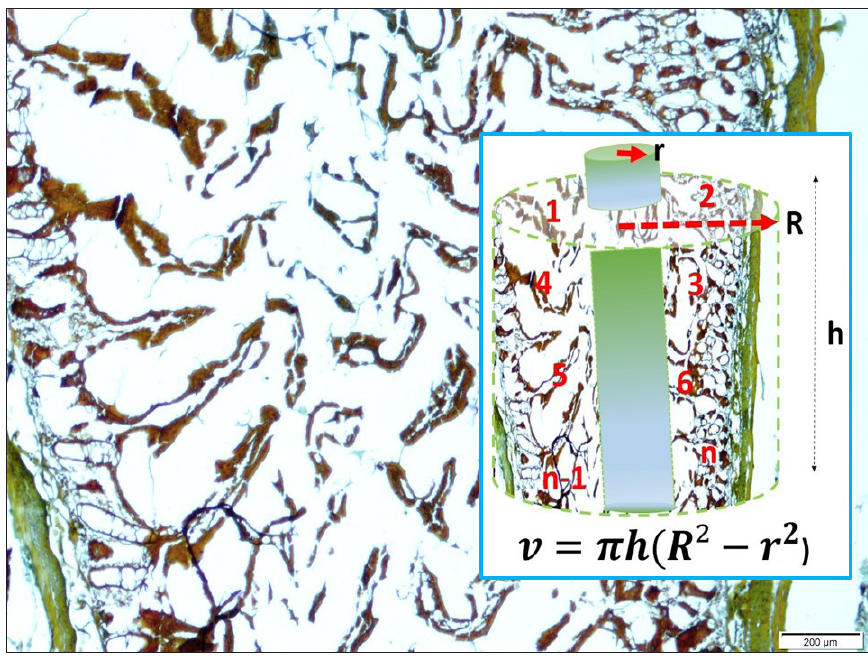
Figure 7. Histological view of the fragmented intestinal villi (LM, Aldehyde Fuchsin, x10/A) and degenerated villi (LM, Aldehyde Fuchsin, x4/Base) of a study animal. In the intestines considered to be cylinders, the number of cells per millimeter square was determined by dividing the inner wall surface area by the cell surface